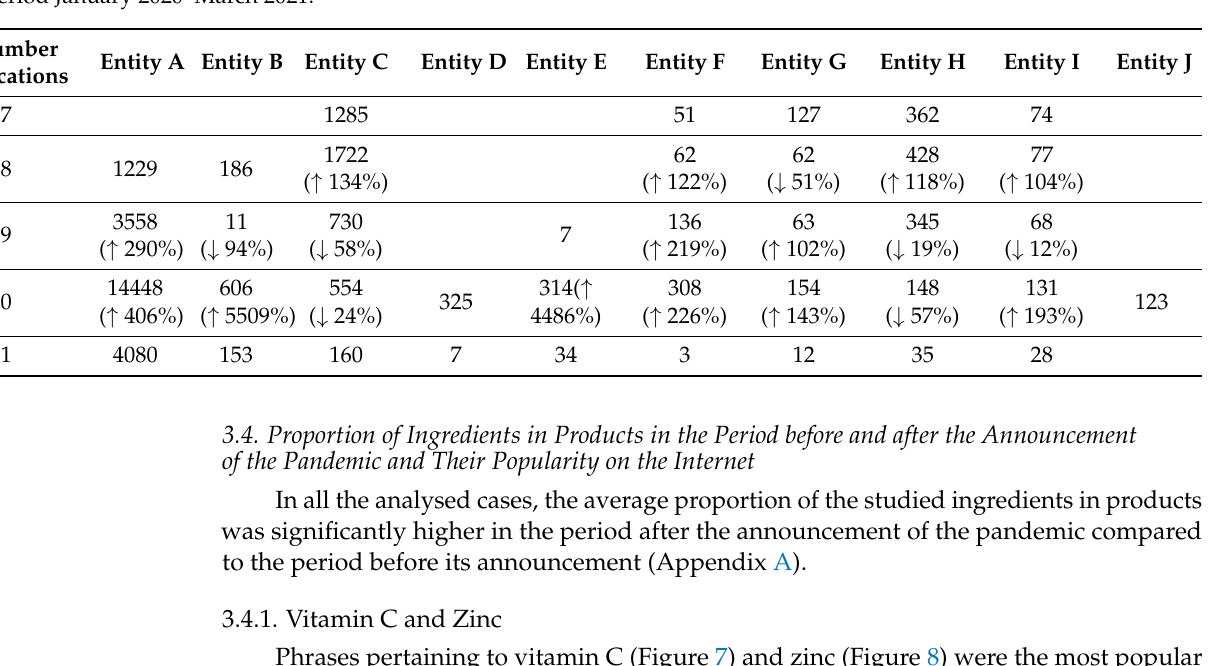
Table 1. Number of notifications on placing new functional food on the market made by the ten most active companies in the period January 2020–March